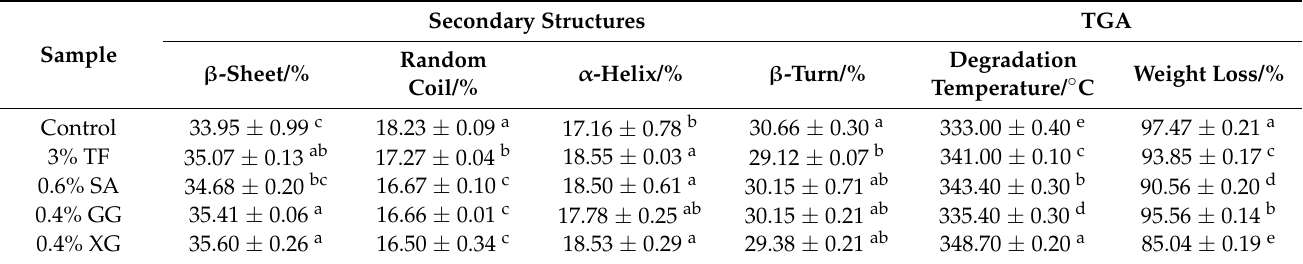
Table 1. Effect of TF, SA, GG and XG on the secondary structure of proteins and TGA characteristic